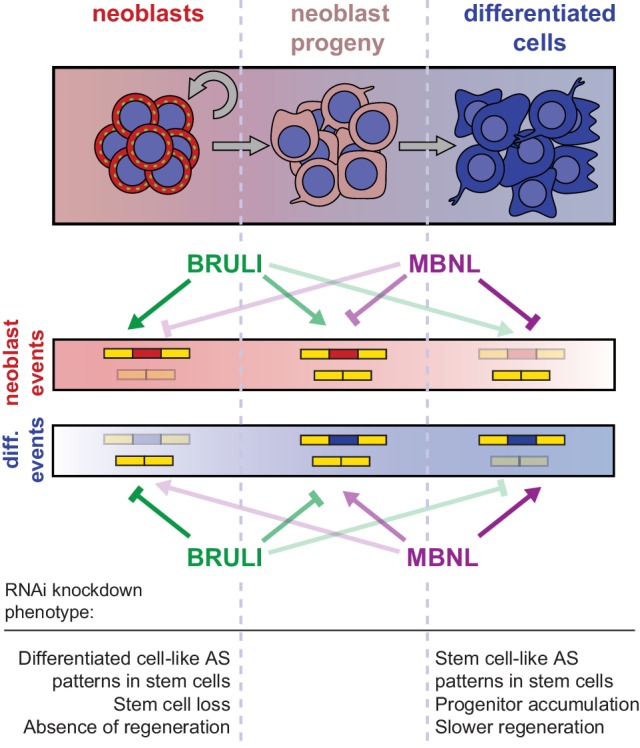
Model for BRULI and MBNL regulation of neoblast-specific AS.Schematic representation of BRULI and MBNL regulation of AS in different planarian cell fractions and respective RNAi mediated knockdown phenotypes.